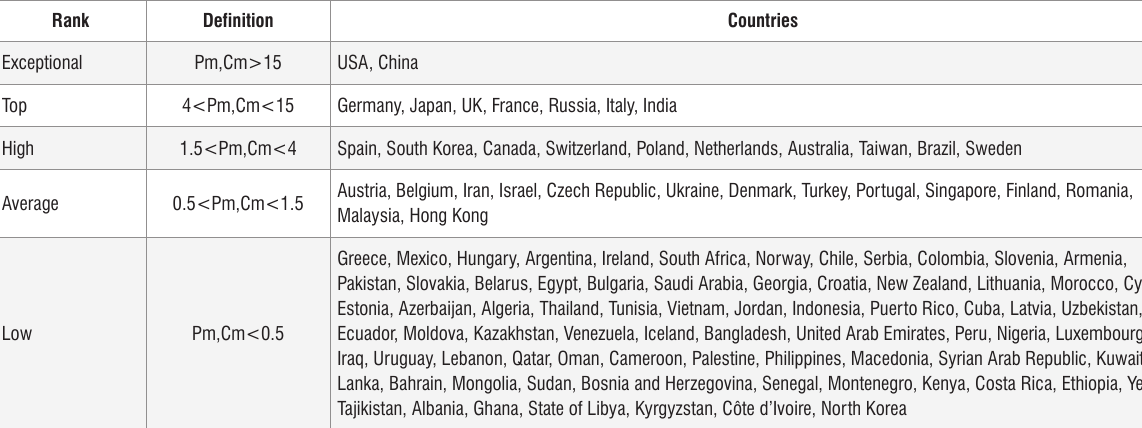
Ranks of countries based on their positions in Pm-Cm diagram